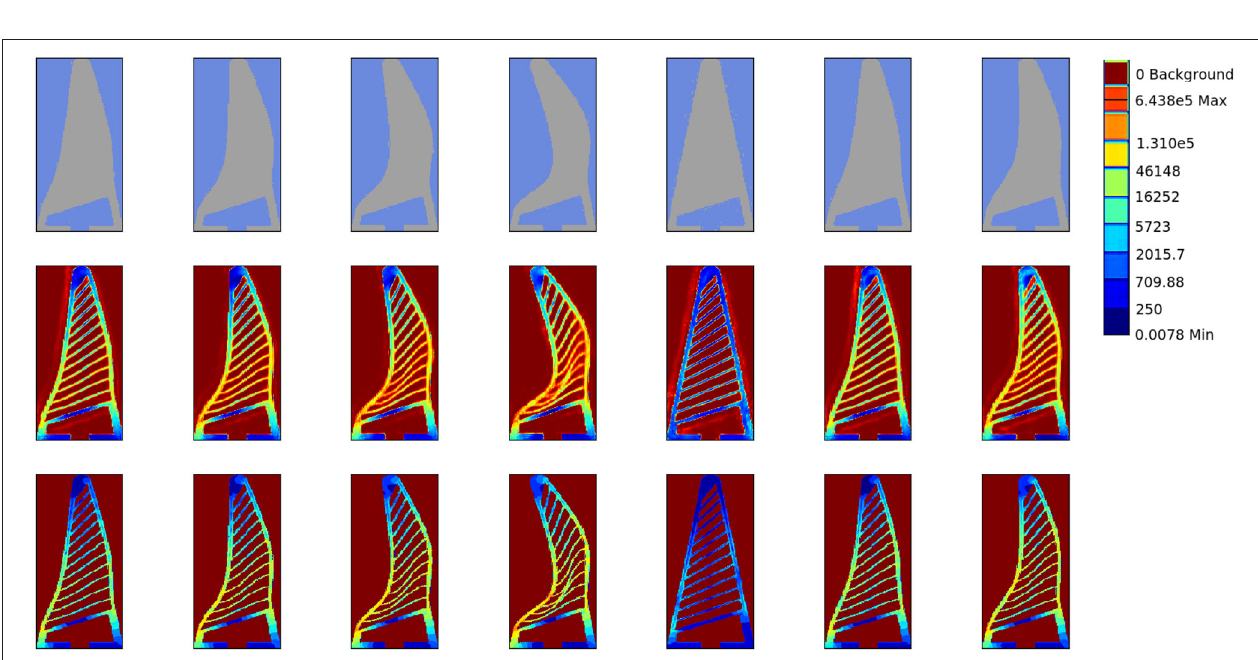
FIGURE 7 | Stress profiling. We qualitatively evaluate the stress profile predicted by our approach in contrast to that generated by FEA simulation. (Top) The input object deformation image to the network, (Middle) The stress map predicted by our network. (Bottom) The ground truth stress map obtained by FEA. The stress values are on logarithmic scale and normalised between [0,1]. Note that these test shapes are not previously seen by our network in the training data. Our approach is able to reconstruct the fine rib structure from deformation